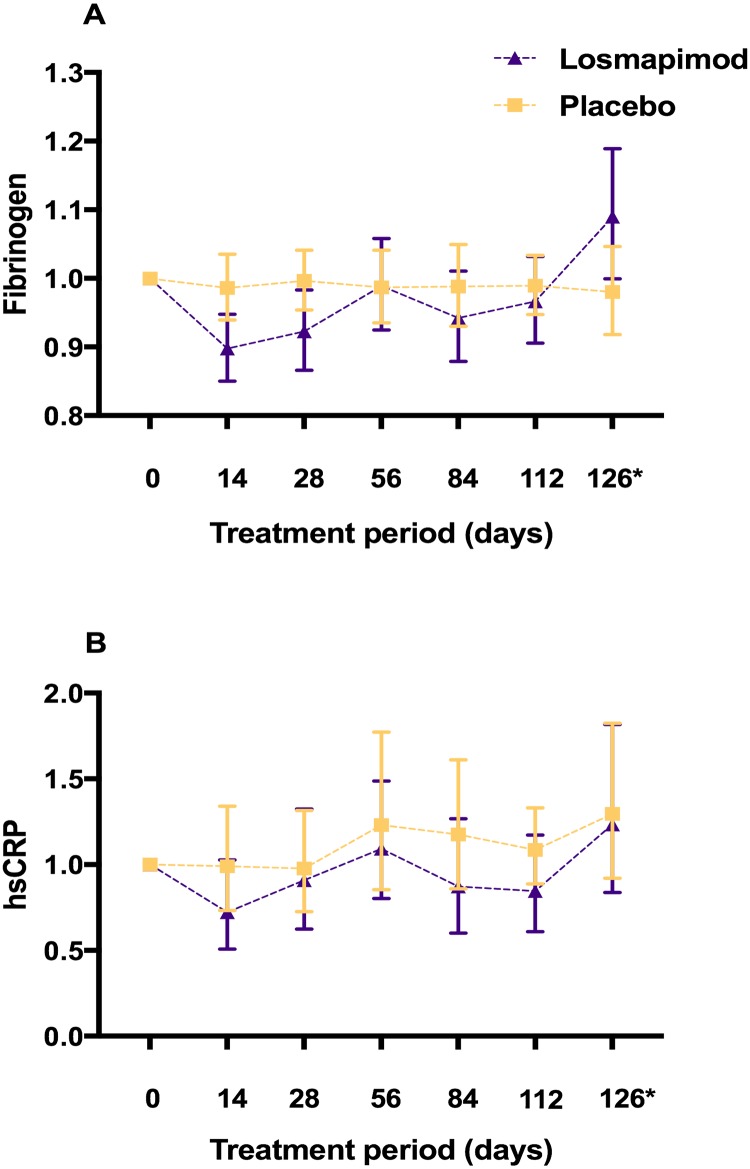
A) Plot of fibrinogen in the losmapimod and placebo treatment groups. Geometric mean of ratio to baseline value (95% CI) represented. *off drug B) Plot of hsCRP in losmapimod and control groups. Geometric mean of ratio to baseline value (95% CI) represented. *off drug.